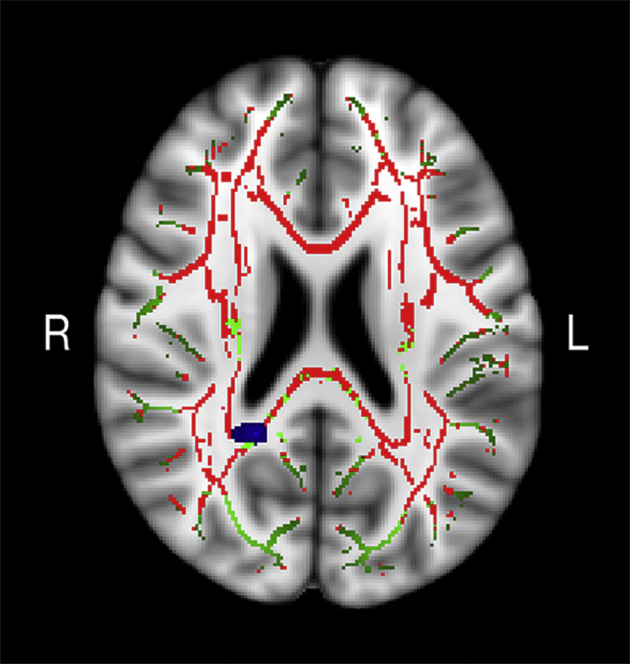
AD cluster related to memory improvement. AD Cluster (21 voxels) shown in blue. Axial view of Talairach coordinates x = 90, y = 137, and z = 94, overlaid on the conjunction mask (in red), the mean FA skeleton (in green) and the standard MNI152 T1 1-mm3 brain template. The results are thresholded at p < 0.05 and corrected for multiple comparisons. Significant areas are dilated for illustrative purposes. Abbreviations: AD, axial diffusivity; FA, fractional anisotropy.